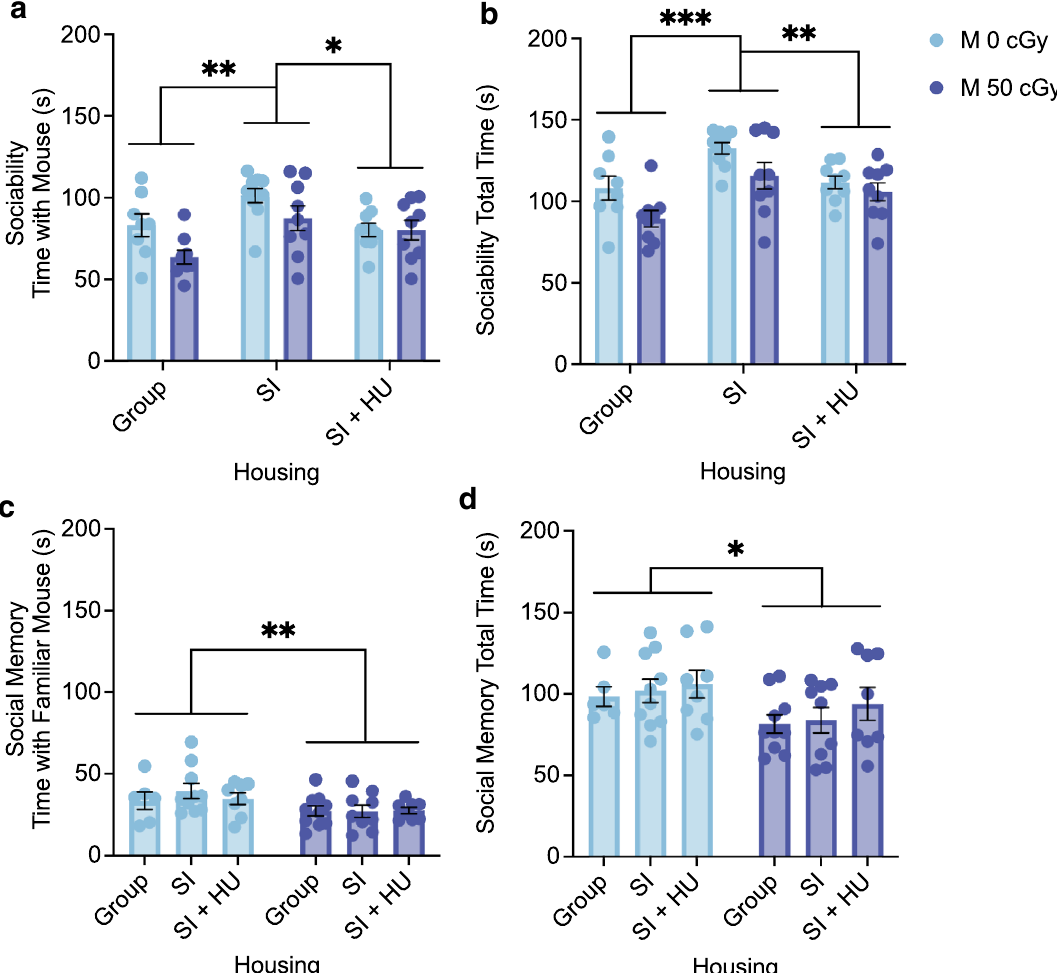
Figure 4. Combined stressors induce differences in social exploration. The three chamber social approach task was used to assess sociability and social memory. ( a ) The main effect of Housing on Time spent with the Mouse during the Sociability phase was F(2,48) = 7.312, p = 0.002, η 2 = 0.234. SI mice spent significantly more time (s) with the social mouse than did Group (mean diff 20.966, 95%CI (7.005 to 34.926), p = 0.002) or SI + HU housed mice (mean diff 14.090, 95%CI (0.348 to 27.831), p = 0.043). ( b ) The main effect of Housing on Total Time spent with the Mouse + Cage was F(2,48) = 10.052, p < 0.001, η 2 = 0.295. SI mice spent more total time than Group (mean diff 25.475, 95%CI(11.202 to 39.711), p < 0.001) or SI + HU housed mice (mean diff 15.444, 95%CI(1.412 to 29.476), p = 0.026). ( c ) The main effect of GCR on Time spent with the Familiar Mouse during the Social Memory phase was F(1,45) = 7.378, p = 0.009, η 2 = 0.141. 50 cGy irradiated mice spent significantly less time with the Familiar mouse than did 0 cGy control mice (mean diff − 8.581, 95%CI (− 14.944 to − 2.218), p = 0.009). ( d ) The main effect of GCR on total time spent with mice was F(1,45) = 6.024, p = 0.018, η 2 = 0.118. 50 cGy irradiated mice spent less total time than 0 cGy control mice (mean diff − 15.698, 95%CI (− 28.579 to − 2.816), p = 0.018). (SI = Social Isolation, HU = Hindlimb Unloading) Sociability Males: N = 9 for all groups except Group 0 cGy (n = 8) and SI 0 cGy (n = 10). Four animals were removed because due to errors in the task, and one because %Time with Mouse exceeded the 85% threshold. Social Memory Males: n = 10 for Group 50 cGy and SI 0 cGy, n = 9 for SI 50 cGy, n = 8 for SI + HU 0 cGy and SI + HU 50 cGy, and n = 6 for Group 0 cGy. Eight animals were removed due to errors in the task. One animal was removed due to %Time Novel Mouse exceeding the